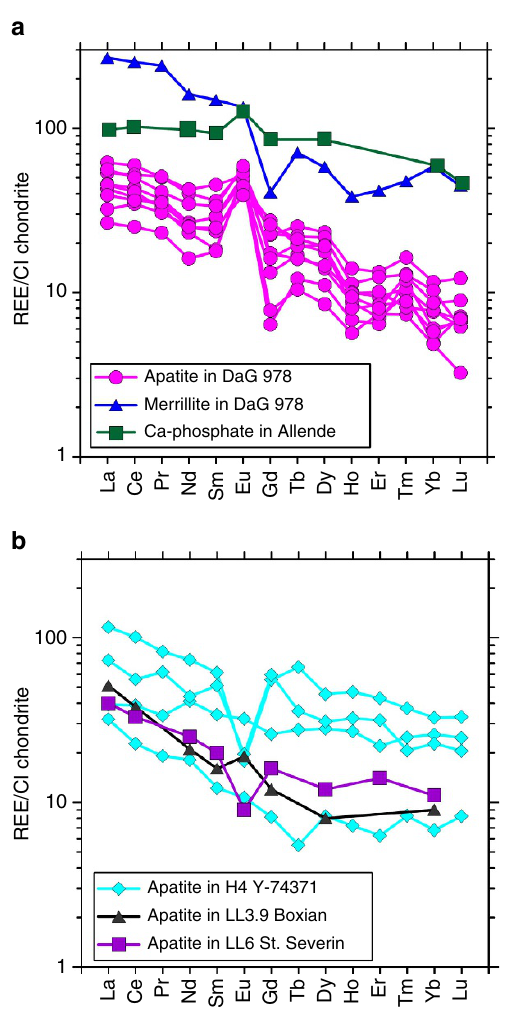
different chondrites. ( a ) Apatite and merrillite in DaG 978, and the Ca–phosphate in Allende have a positive Eu anomaly with heavy rare earth elements slightly depleted than light rare earth elements. ( b ) The rare earth element compositions in apatite in ordinary chondrites, which were determined by SIMS. Note that apatite grains in less equilibrated ordinary chondrites (H4 Yamato 74371 and LL3.9 Boxian) may contain weak, positive Eu anomalies. Data for Ca–phosphates in ordinary chondrites and Allende are from refs